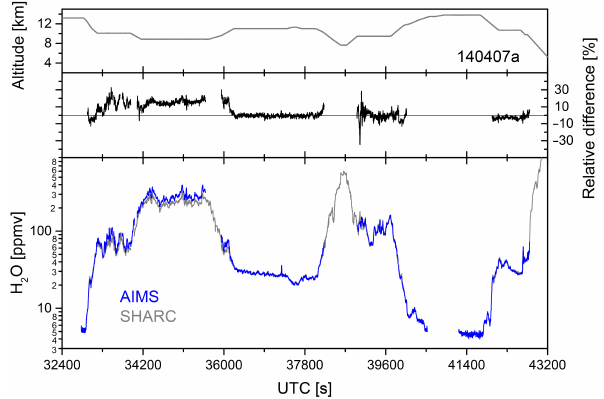
Figure 9. Time series of H 2 O mixing ratio (bottom panel) from a flight on 7 April 2014 during the ML-CIRRUS campaign. The blue curve is the gas phase measurement of AIMS-H 2 O. For com- parison, measured mixing ratios from the SHARC TDL (gray) are shown. For the high mixing ratios between 34000 and 35600s, the sample flow of AIMS-H 2 O was diluted with synthetic air. The top panel shows the flight altitude, the middle panel denotes the relative difference between both instruments. Data from both instruments agree reasonably